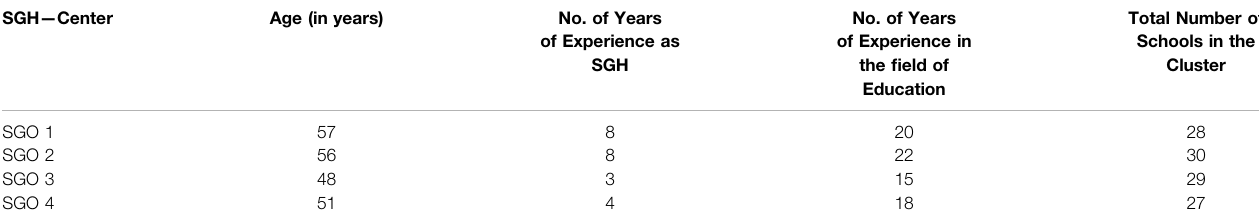
Demographic Data of Second Cycle Sample.